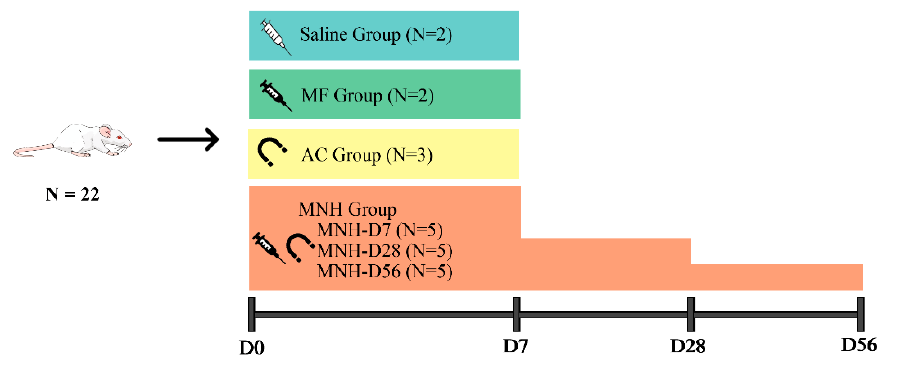
Figure 1. Schematic drawing of the experimental design. Saline Group, animals received an intratesticular injection of sterile saline solution. MF Group, animals received an intratesticular injection of the magnetic fluid. AC Group, animals were exposed to the external AC magnetic field only. MNH Group, animals received an intratesticular injection of the magnetic fluid and were exposed to the external AC magnetic field. Animals were divided into 3 subgroups and evaluated: 7 (MNH-D7 Group), 28 (MNH-D28 Group), and 56 (MNH-D56 Group) days after the magnetic nanoparticle hyperthermia treatment.